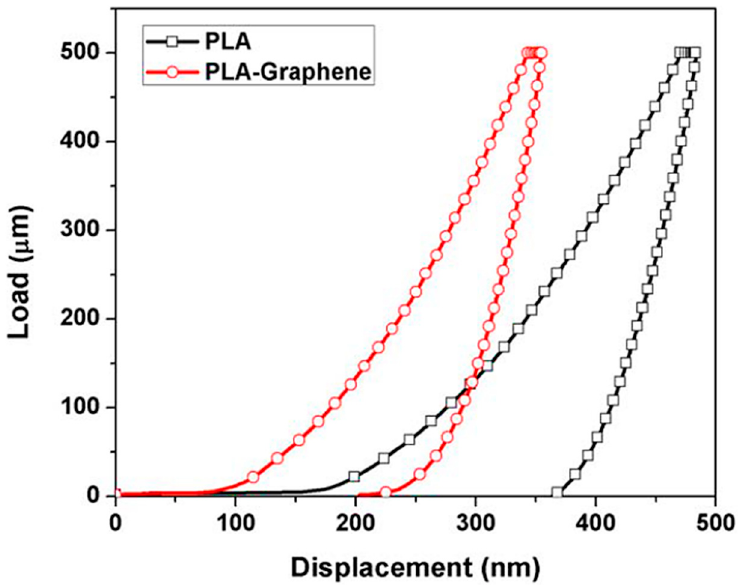
Figure 8. Representative load-displacement curves obtained from nanoindentation of 3D-printed poly(lactic acid) (PLA) and poly(lactic acid)–graphene (PLA-Graphene) [108]. Reproduced with permission from Wiley.